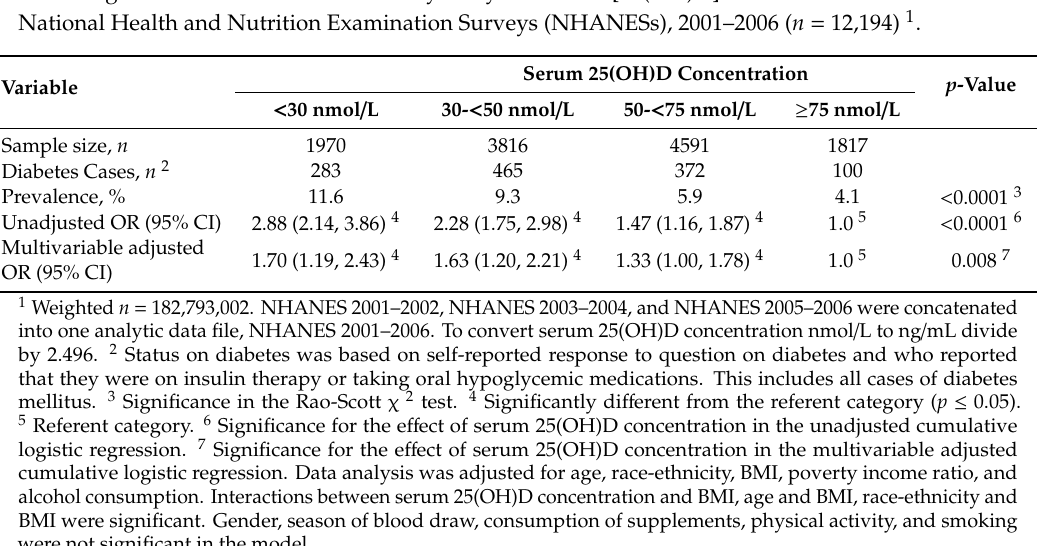
Table 3. Multivariable adjusted odds ratio (OR) and 95% confidence interval (CI) for diabetes risk according to clinical cut o ff serum 25-hydroxyvitamin D [25(OH)D] concentrations in US